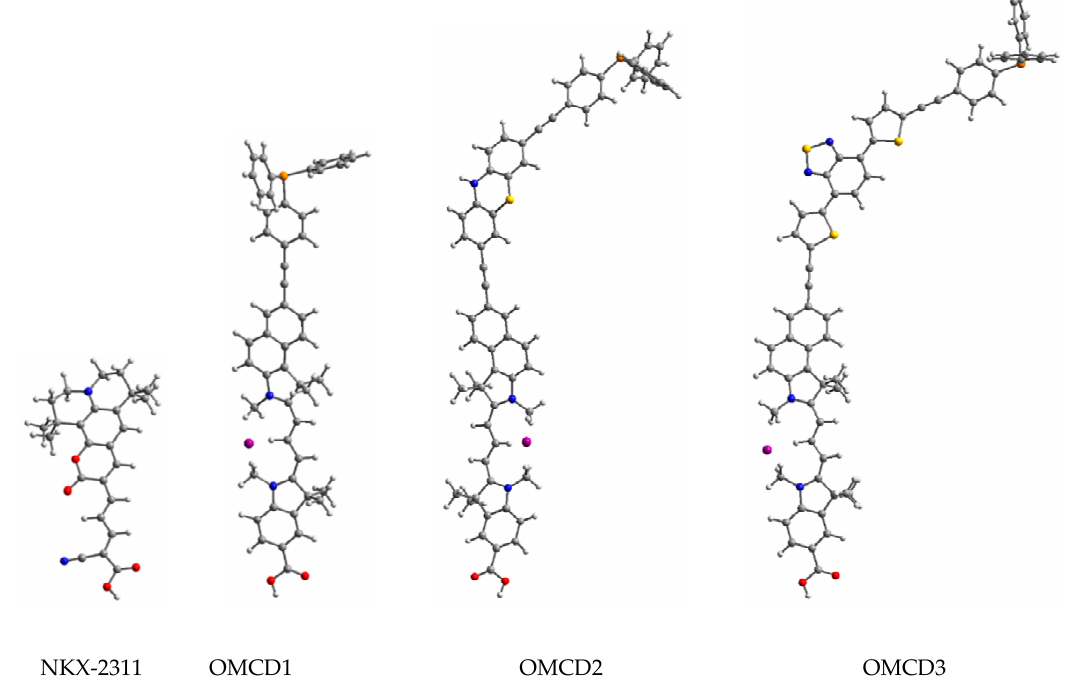
Figure 1. Optimized structure of the dyes in their neutral form, calculated by DFT at B3LYP/DZVP level in ethanol. Color coding: C—grey, O—red, N—blue, S—yellow, P—orange, I—purple, H—light grey, small sphere. Table 1 . The structural parameters of the dyes, obtained after geometry optimization by DFT at B3LYP/DZVP level in ethanol. Geometrical parameters describing the dyes: bond lengths (in Å), the torsion angle of the carboxyl group relative to the indolinium plane, and the dihedral angle defined by the indolinium plane and the plane of the three neighbor Ti atoms on the cluster surface (both in deg). Parameter